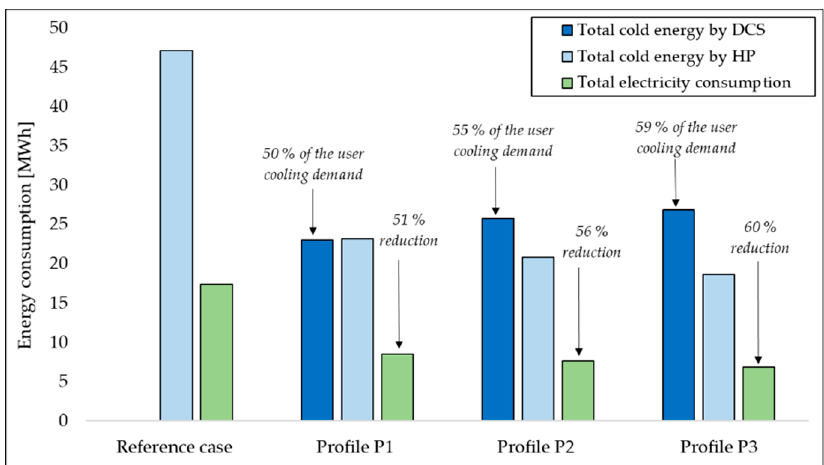
Figure 7. Total district electric consumption and users’ cold energy demand divided into the share provided by DCS and by the backup systems (i.e., HP) with different free cooling power profile (months of July and August) in presence of a cold-water tank of 60 m 3 .